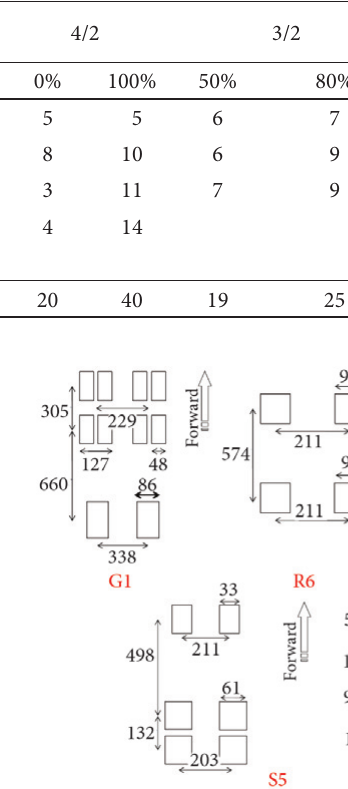
Fig. 2. Dimensions for test vehicles (dimension unit –